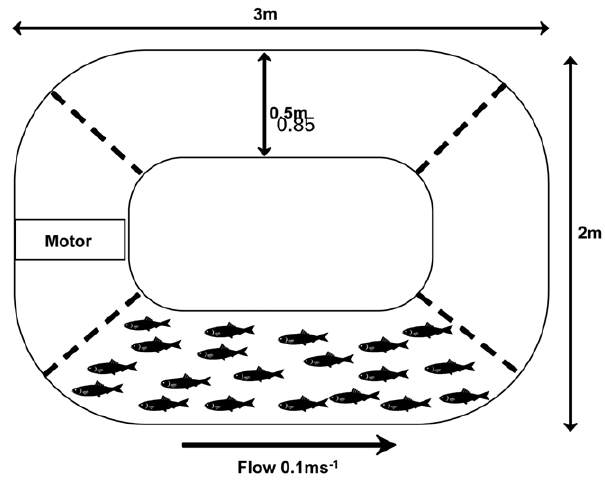
Figure 1. Design of experimental tanks. Fish were confined to one side of the tank, to aid behavioral observations, using mesh barriers (represented by dashed lines).